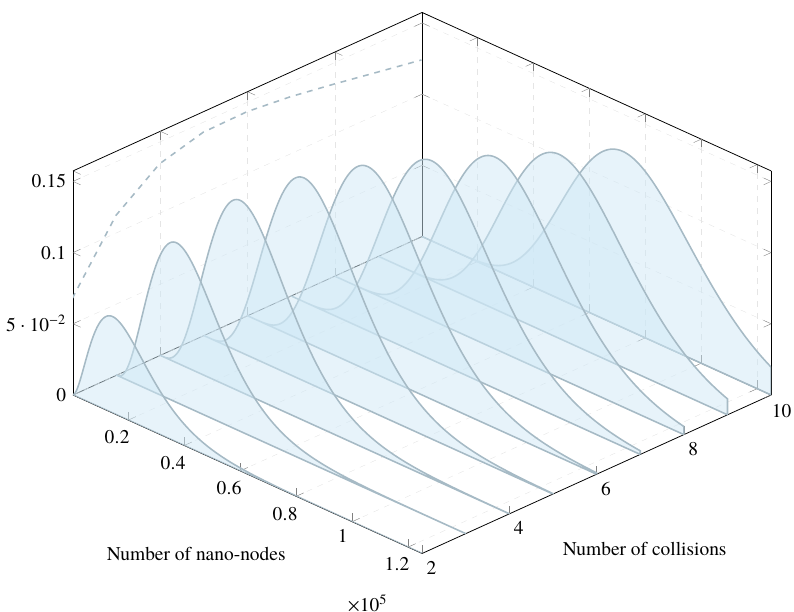
Figure A1. Probability of frame collisions for A = 2 × 10 − 3 m, f = 1Hz, σ = 2, and t f = 0.